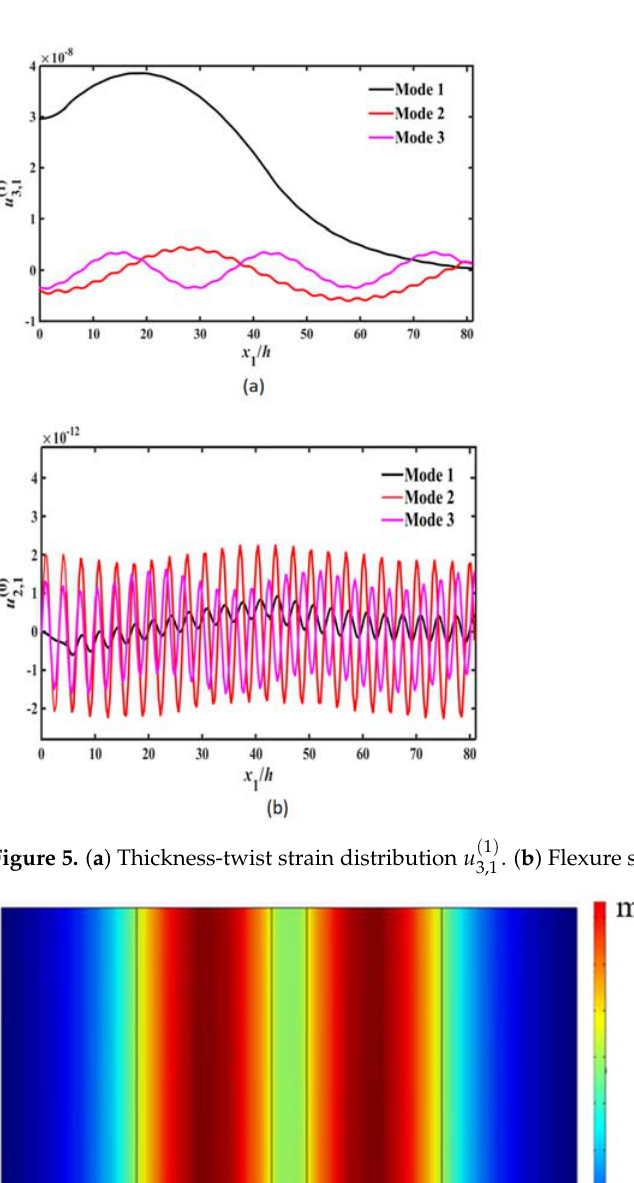
Figure 6. The vibration mode shape of the device obtained from COMSOL Multiphysics.